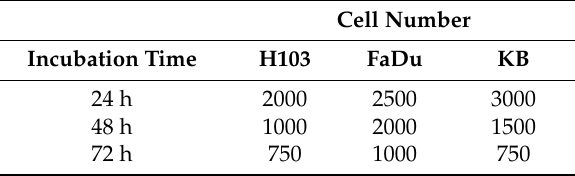
Table 2. The number of cells seeded for MTT assay after 24, 48 and 72 h incubation with